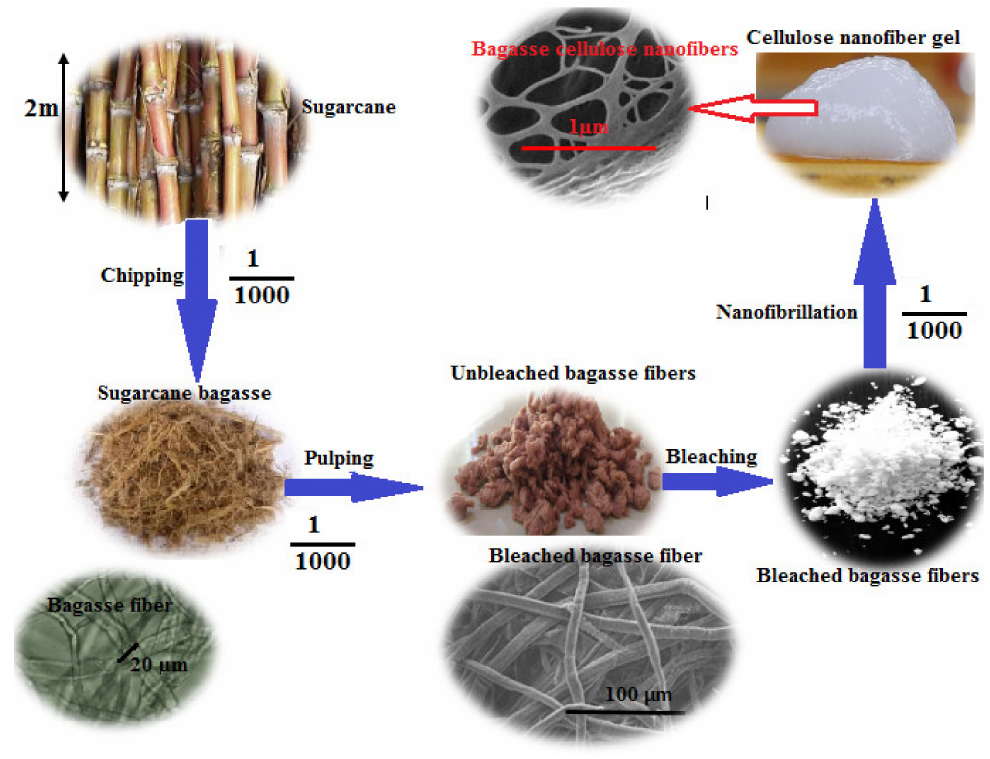
Figure 1. Top-down approach for preparation of cellulose nanofibers (CNFs) from